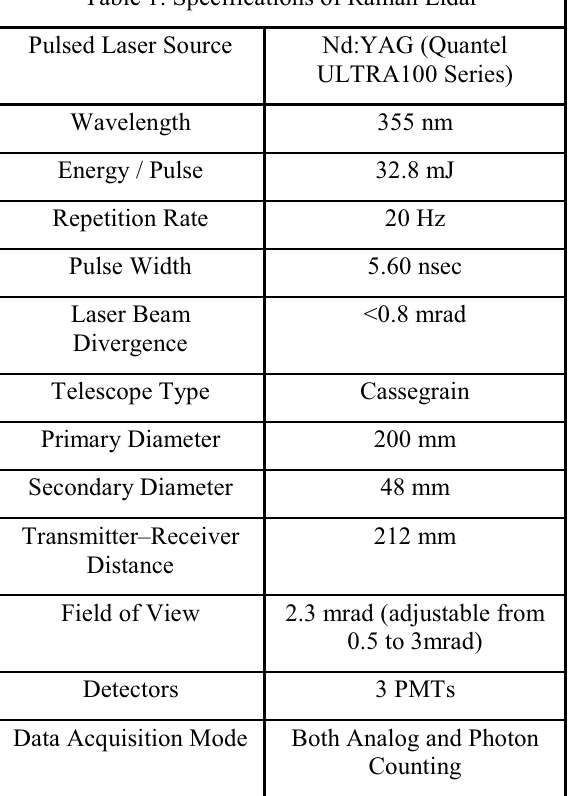
Table 1: Specifications of Raman Lidar Pulsed Laser